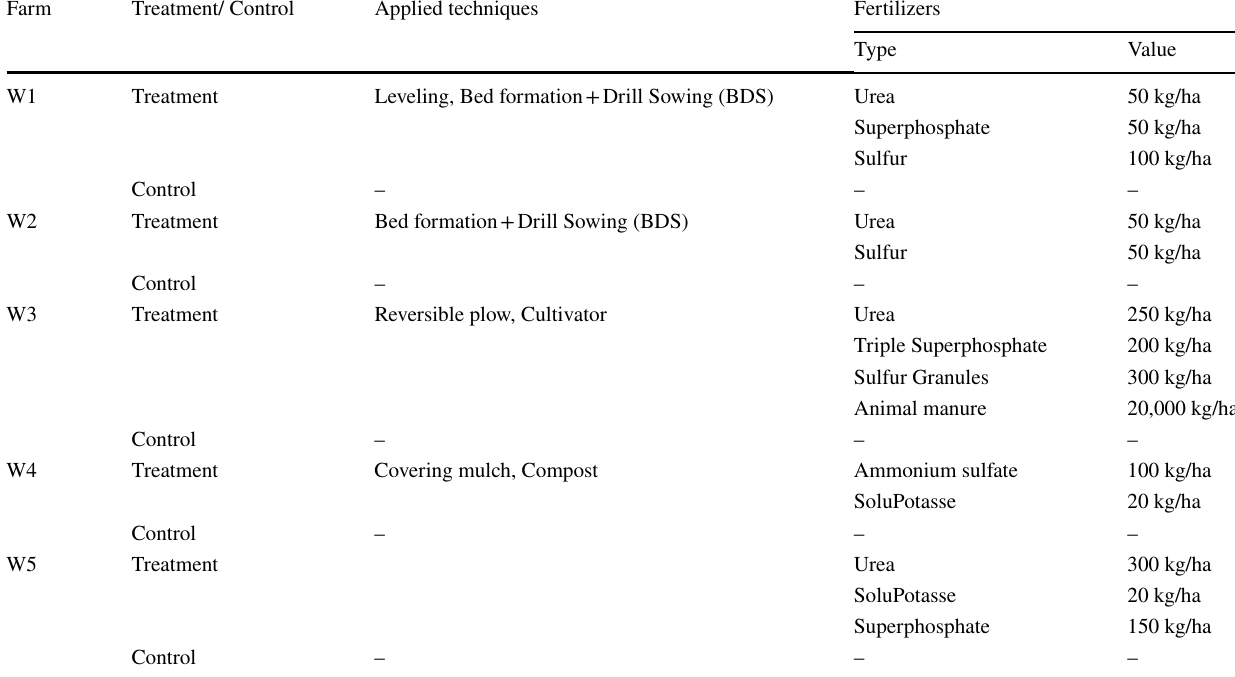
Table 3 Applied techniques and fertilizers used Farm Treatment/ Control